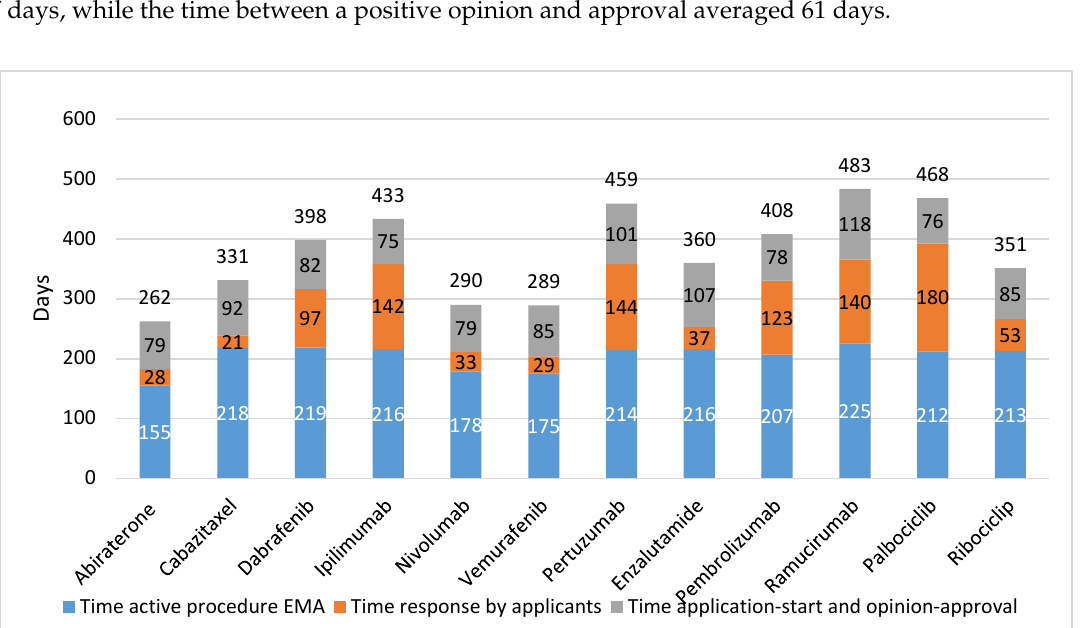
Figure 2. EMA trajectory of 12 newly registered oncological drugs (in days). EMA: European Medicines Agency.